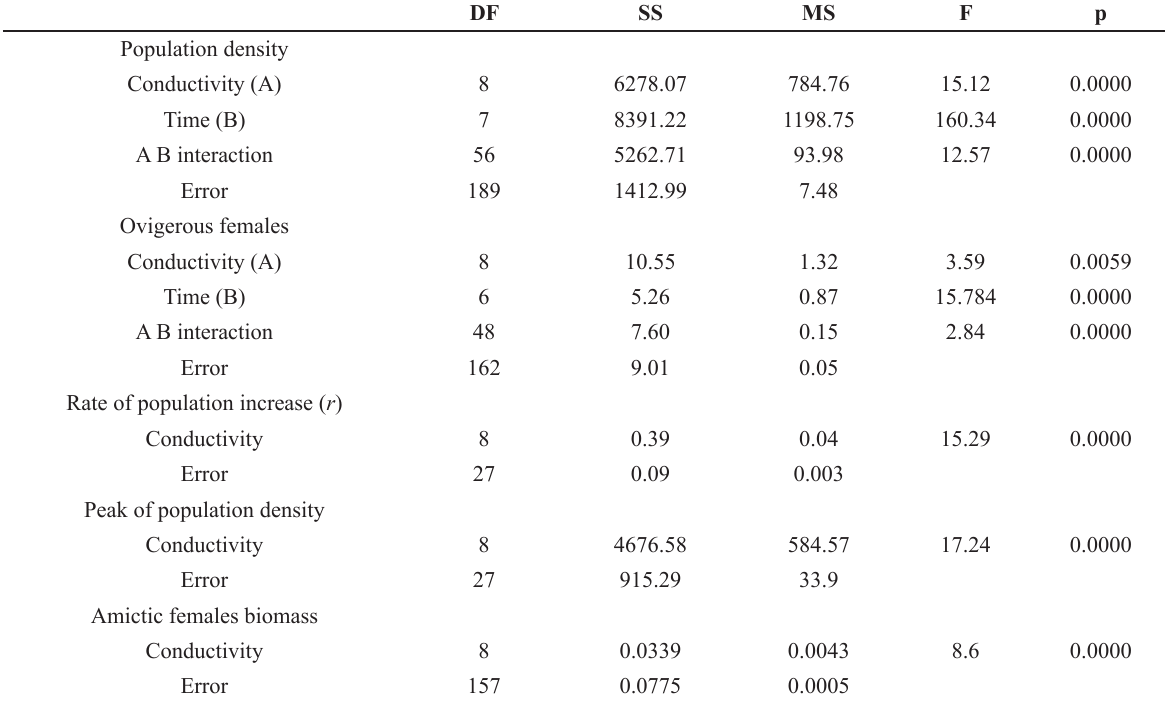
Statistical evaluation by the RM-ANOVA of the total population and ovigerous-female densities of Brachionus plicatilis and by the one-way ANOVA of the rate of population increase, the peak of population density and the biomass of the rotifer cultured at different conductivities (DF = degrees of freedom, SS = sum of the squares, MS = mean square, F = F-ratio, p = p